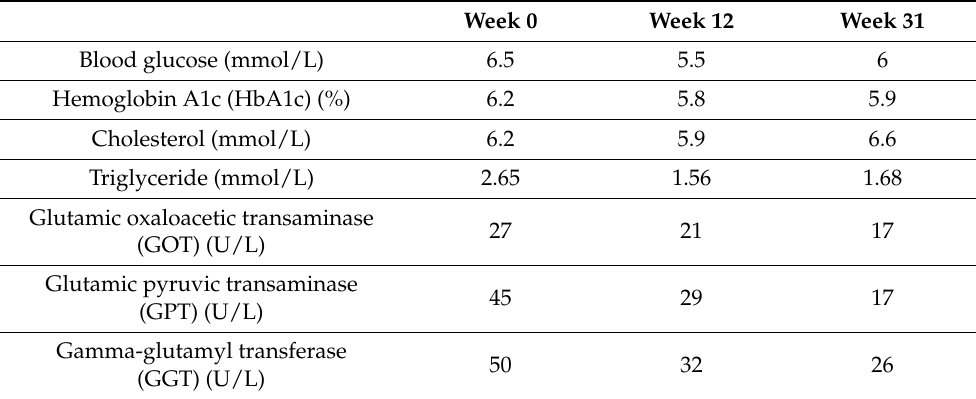
Table 1. Results of blood test during the